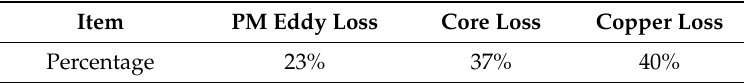
Table 5. Percentage of the distributed power loss of the CADMP-FSPM